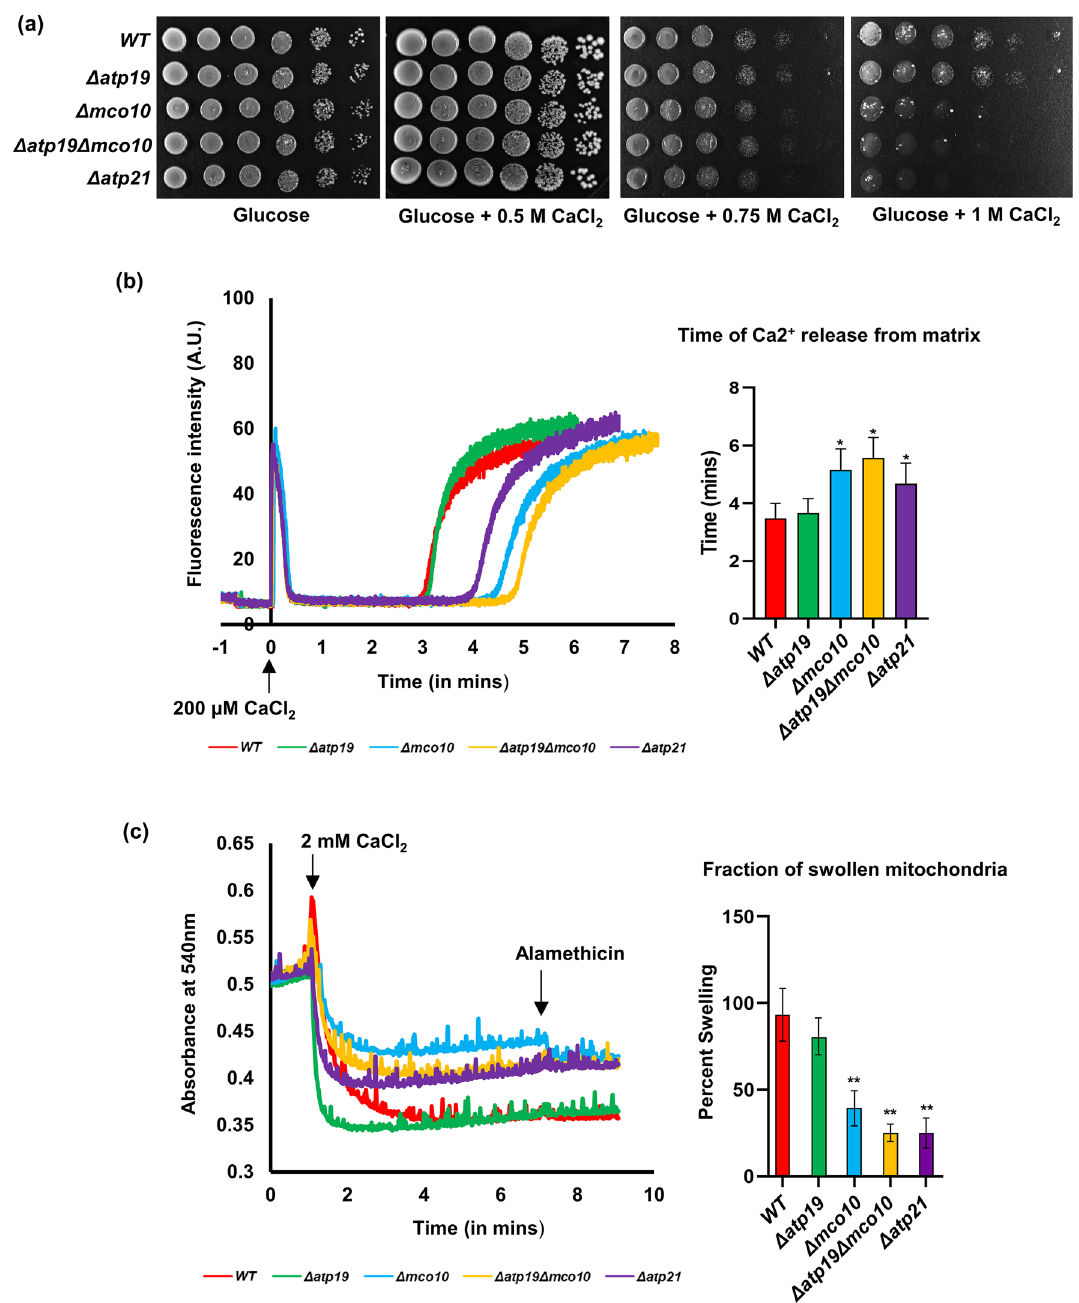
Figure 7. Mco10 modulates the yPTP. ( a ) Cells from the indicated strains grown in glucose pre-cultures were serially diluted, spotted on rich glucose plates supplemented with 0.5 M, 0.75 M and 1 M CaCl 2 and incubated at 28 °C. Plates were photographed after four days of incubation. ( b ) The yPTP induction time measured in the CRC experiment. 1 mg of mitochondria was added to CRC buffer containing the calcium ionophore ETH129 and the calcium green-5N calcium indicator, and 200 µM CaCl 2 was added at time 0. The experiment was monitored till the rapid increase of the calcium in the buffer. Traces are representative of at least 3 independent experiments and the histogram refers to the time needed for calcium release. ( c ) Mitochondrial swelling assay. Swelling was induced by the addition of 2 mM CaCl 2 to 1 mg of mitochondria suspended in swelling buffer containing the ETH129 and measured as the decrease in absorbance at 540 nm. Alamethicin (10 µM) was added after 2.5 min of swelling for normalization of the experiment. The histogram refers to the fraction of swollen mitochondria after completion of the process 2.5 min after calcium addition. The representative plates and curves are shown. Statistical significance of differences versus control mitochondria is indicated by * p ≤ 0.05; ** p <